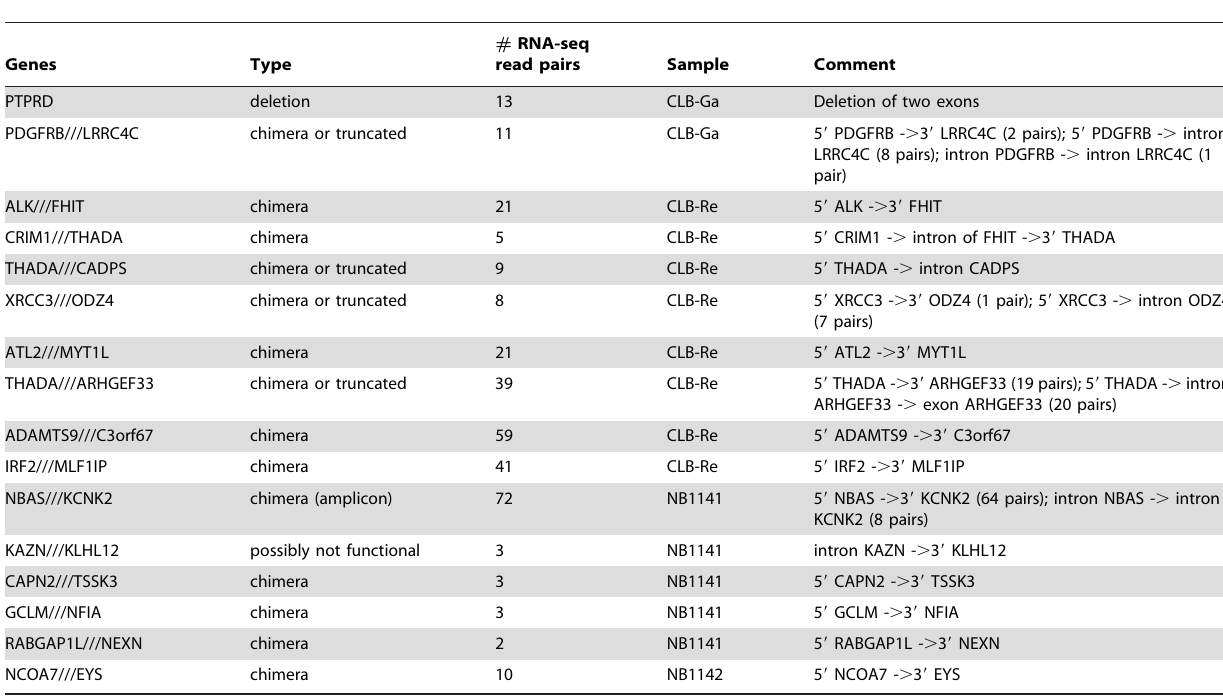
Table 4. Abnormal transcripts confirmed with RNA-seq.